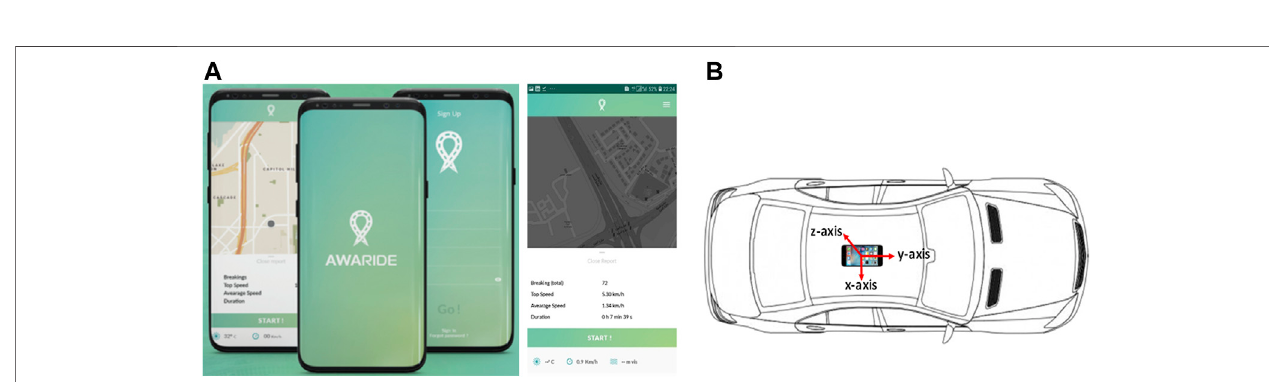
FIGURE 6 | (A) The AWARIDE mobile app; (B) Orientation of the smartphone with respect to the vehicle.